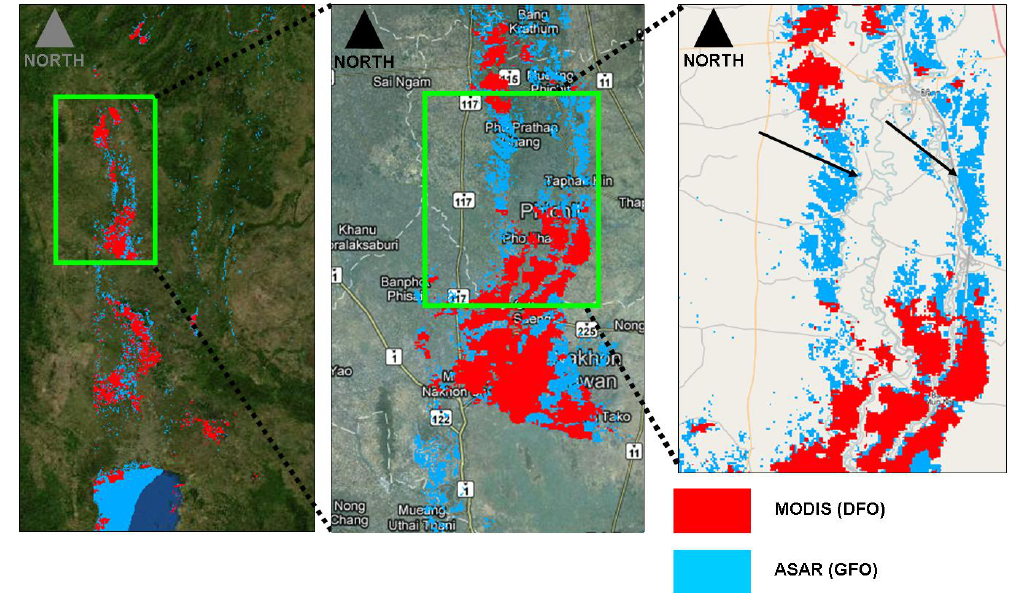
Fig. 9. The Chao Phraya basin at different zoom levels. Left panel: largest extent. Towards right panels: zoomed extents. Flood classification Figure 9. The Chao Phraya basin at different zoom levels. Left: largest extent. Towards right: 3 from Envisat ASAR WSM is shown in blue and is underlying the flood classification based on MODIS in red. zoomed extents. Flood classification from Envisat ASAR WSM is shown in blue and is 4 map, shown in Fig. 10 (top right panel), has been created us- underlying the flood classification based on MODIS in red. 5 ing a probability algorithm with a subsequent